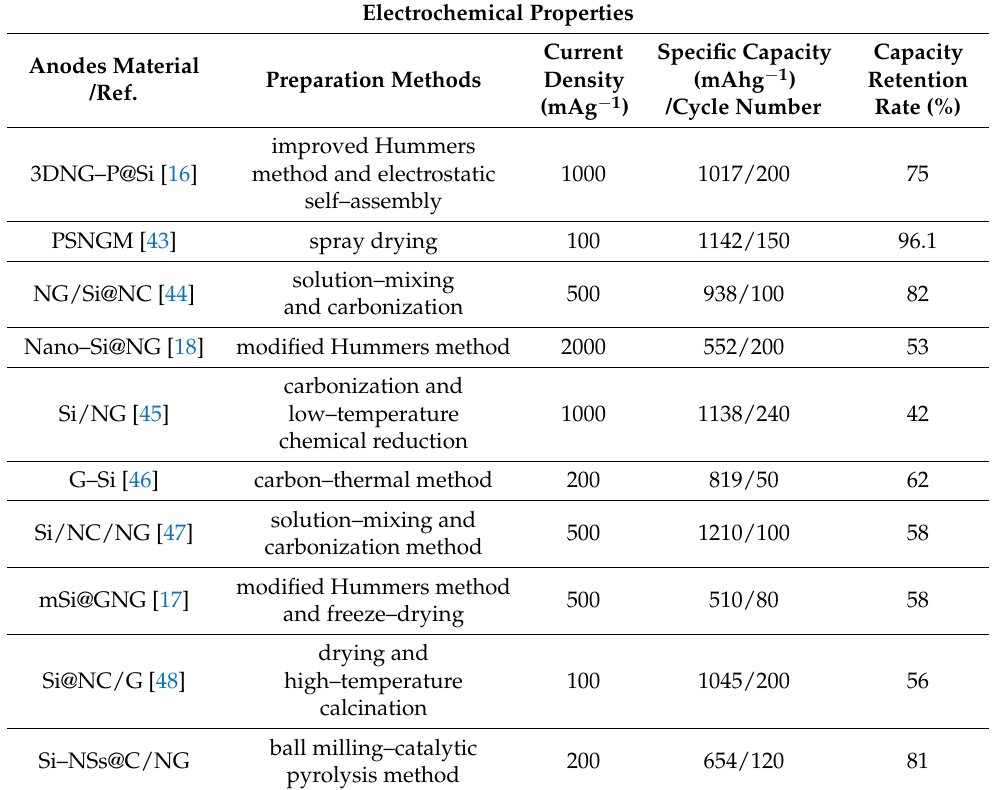
Figure 7. ( a ) Galvanostatic charge/discharge curves for the first cycle of Si–NSs, NG and Si– NSs@C/NG; ( b ) galvanostatic charge/discharge curves of Si–NSs@C/NG at 5th, 20th, 50th,100th, and 120th at 200 mA g − 1 ; ( c ) cycling performance of Si–NSs, NG, and Si–NSs@C/NG at 200 mA g − 1 ; ( d ) rate performance of Si–NSs, NG, and Si–NSs@C/NG. Table 1. Comparisons of the electrochemical performance of Si–NSs@C/NG with other silicon/N– doped graphene anodes in Li–ion half